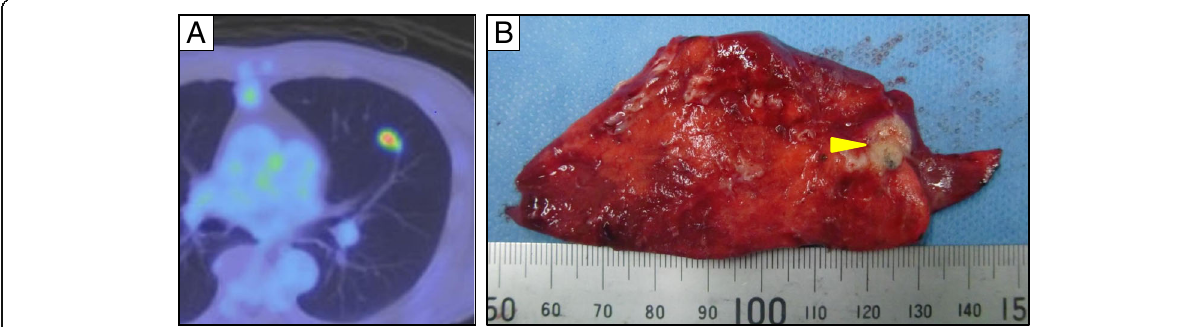
Fig. 2 PET-CT and resected specimen of the left lung. a PET-CT showing the accumulation of FDG in the metastatic lesion in the left lung. b Specimen of the lung after metastasectomy (arrowhead shows the